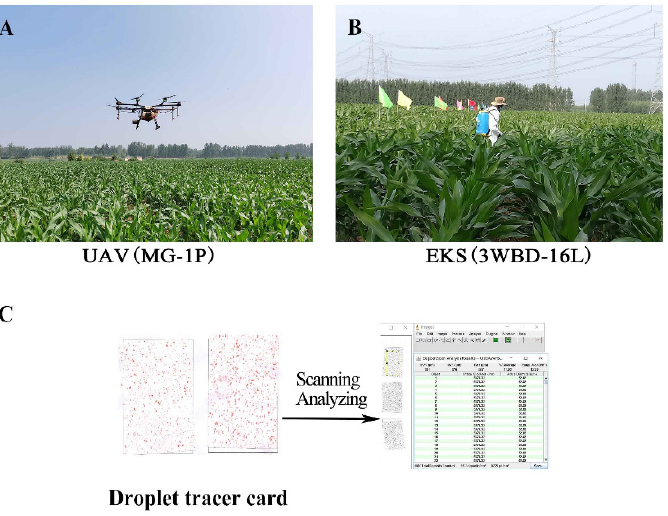
Figure 3. The spray equipment and droplet tracer card. ( A ) MG-1P. ( B ) 3WBD-16L.( C ) Droplet tracer card.